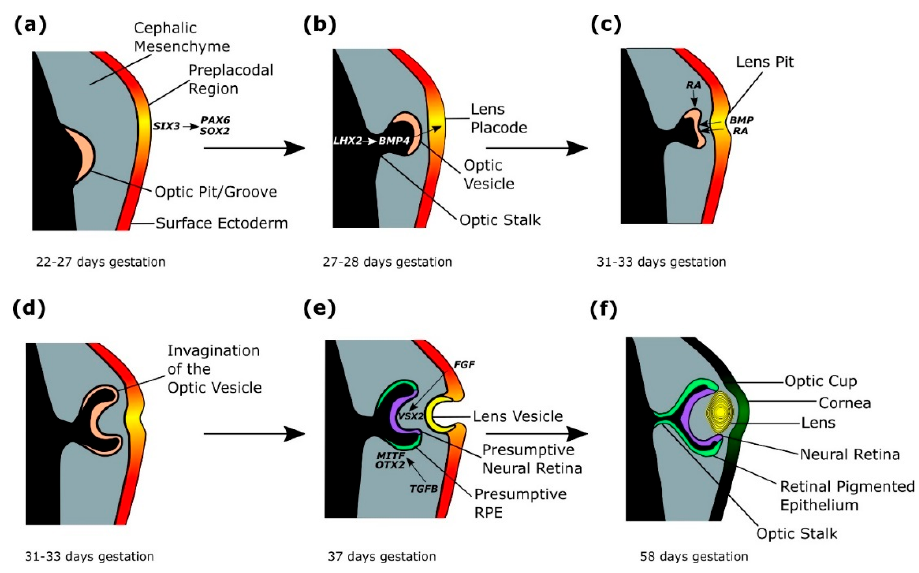
Figure 3. The genetics of optic cup and lens formation. ( a ) A preplacodal region develops within the surface ectoderm overlying the optic pit / groove, stimulated by expression of SIX3 , which activates PAX6 and SOX2 . ( b ) The lens placode is signalled to thicken through LHX2 -regulated BMP4 expression from the evaginating optic vesicle. ( c ) The developing lens placode releases BMP and retinoic acid (RA), which bind to the optic vesicle, stimulating coordinated invagination of the optic vesicle and lens placode, which forms the lens pit. ( d ) The invagination of the optic vesicle results in the formation of a bilayered optic cup. ( e ) TGF β signalling from the extraocular mesenchyme induces and maintains MITF and OTX2 expression in the outer layer of the optic cup, which forms the presumptive retinal pigmented epithelium (RPE). FGF signals from the surface ectoderm stimulate the inner layer of the optic cup to form a VSX2 -expressing presumptive neural retina (NR). The continued invagination of the lens pit results in the formation of the lens vesicle. ( f ) From 47 days gestation, retinal di ff erentiation occurs, with the inner layer of the optic cup forming the neural retina (NR) and the outer layer forming the retinal pigmented epithelium (RPE). The lens vesicle detaches from the surface ectoderm and forms a definitive lens by 58 days